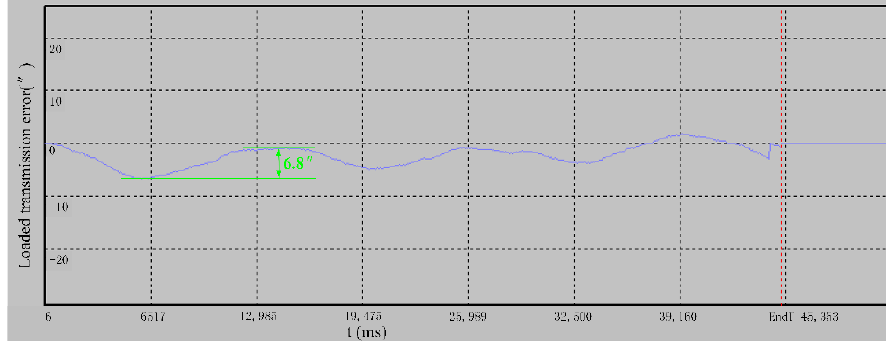
Figure 12. Actual LTE of the gear pair.